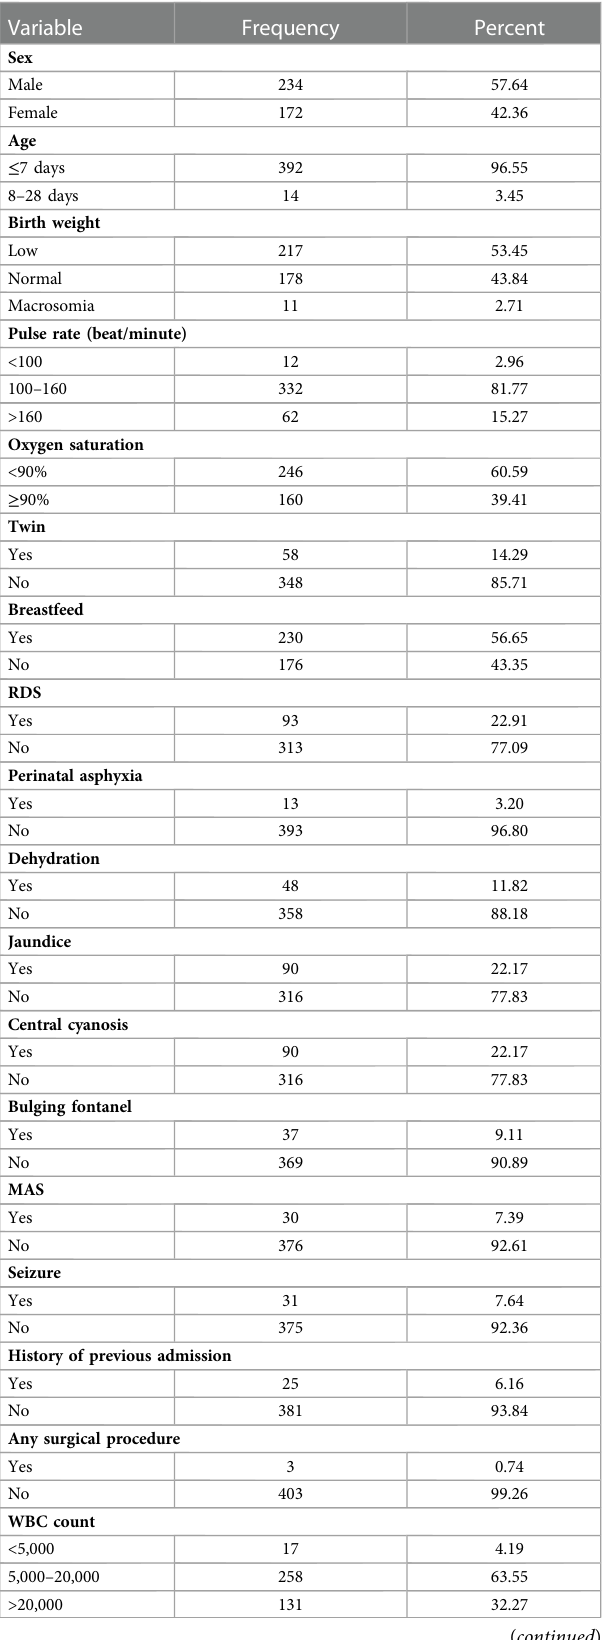
TABLE 2 Baseline characteristics of the neonates admitted with sepsis at NICU in referral hospitals of northwest Ethiopia, 2021 ( N =406).